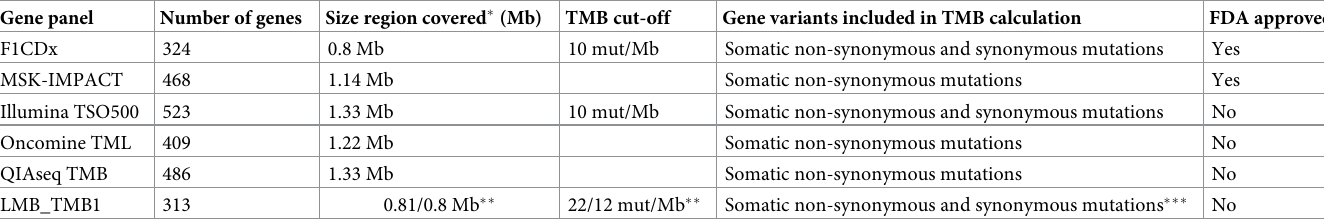
� Coding region used to estimate TMB regardless of the size of the region assessed by the panel. �� The approach for TMB calculation including HLA genes / the approach for TMB calculation excluding HLA genes. ��� Non-synonymous mutations include SNPs and short insertions and deletions